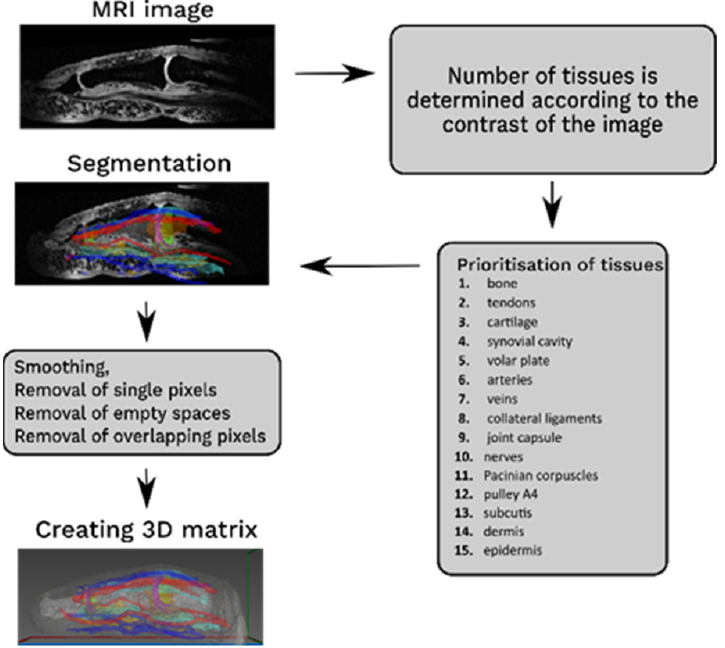
Figure 1. Segmentation protocol, in which segmented tissues were prioritized, smoothed, and transformed into a 3D matrix.